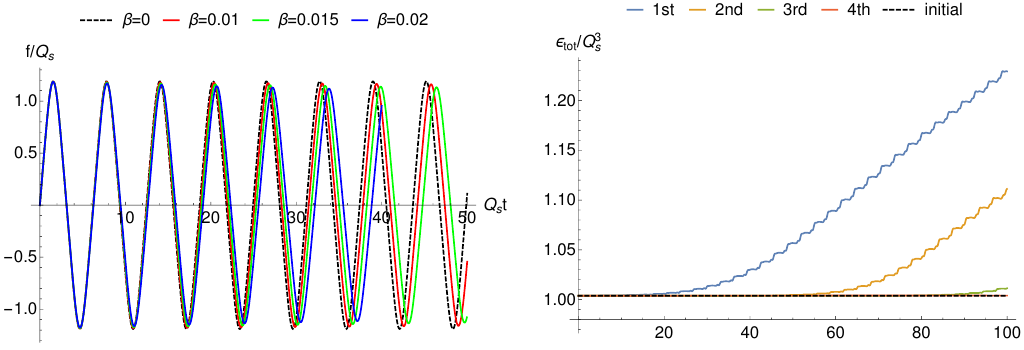
Figure 2 . Left: the YM gauge (cid:12)eld. Right: total energy for (cid:12) = 0 : 01 as function of time for subsequent